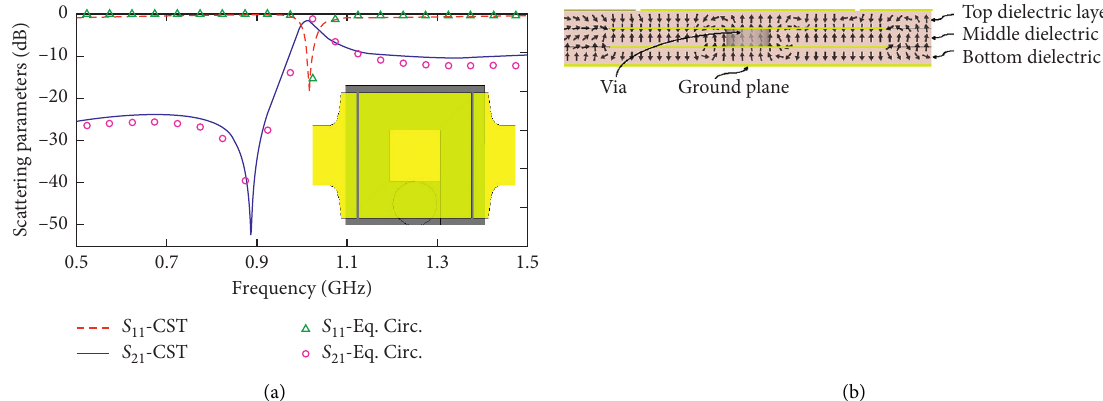
Figure 4: (a) The scattering parameters of the DNG cell, and (b) the electric field distribution over the cross section of the multilayer printed circuit board (at the middle of the structure) at 1GHz, where the parameters indicated in Figure 1(a) are set as, a � 12.9 mm, w � 4.3mm,